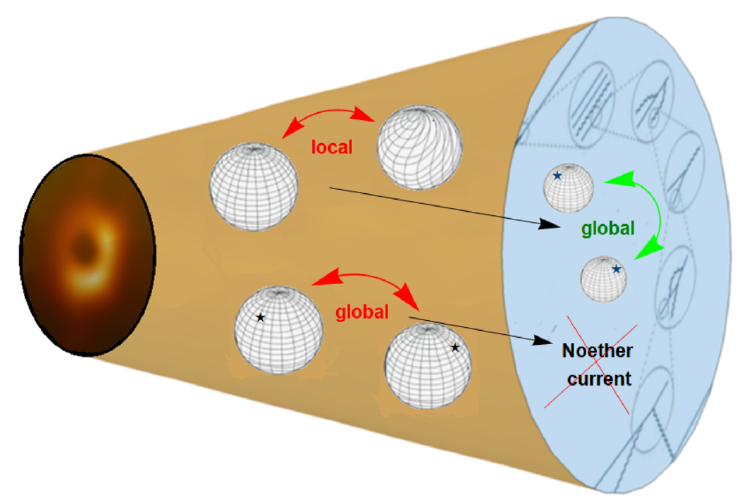
Figure 8: The holographic picture. Local (gauge) symmetries in the bulk map into global symmetries in the boundary field theory. Global symmetries in the bulk (e.g. a global rotation) correspond to symmetries without Noether currents / charges in the boundary field